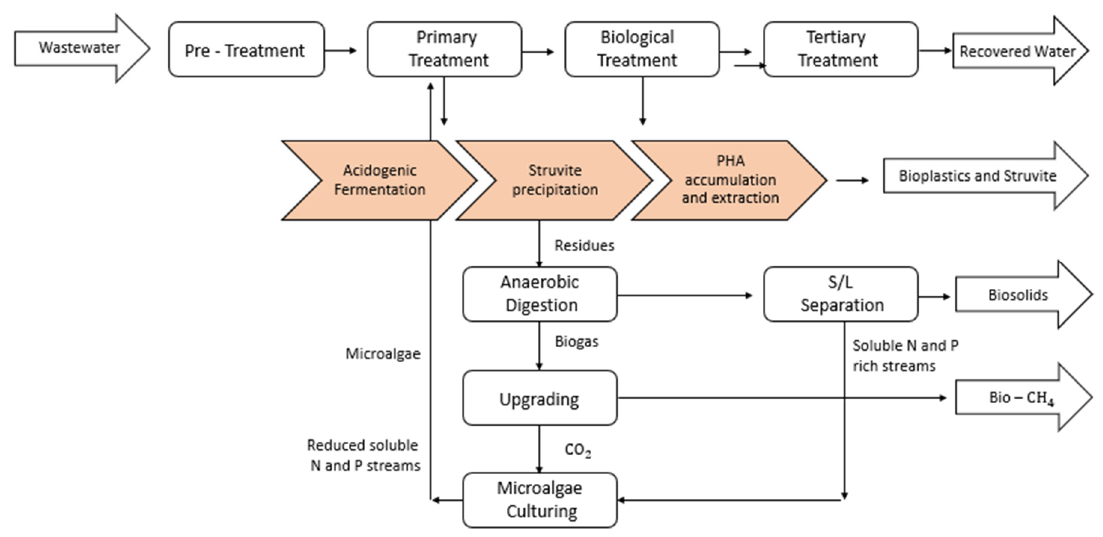
Figure 2. Wastewater treatment scheme for resource recovery (adapted from [63]).